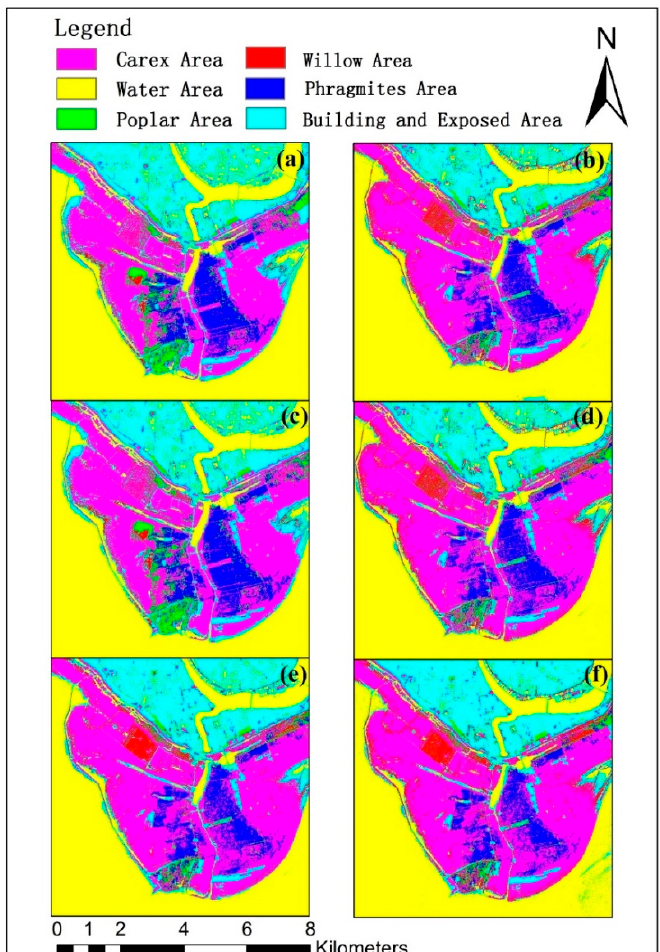
Figure 10. The comparison of land cover type classification maps for one small region located at the east central part of the study area using six methods to select the first four spectral variables: ( a ) JM distances; ( b ) correlation-weighted JM distances; ( c ) Divergences; ( d ) correlation-weighted divergences; ( e ) B-distances and ( f ) correlation-weighted B-distances.